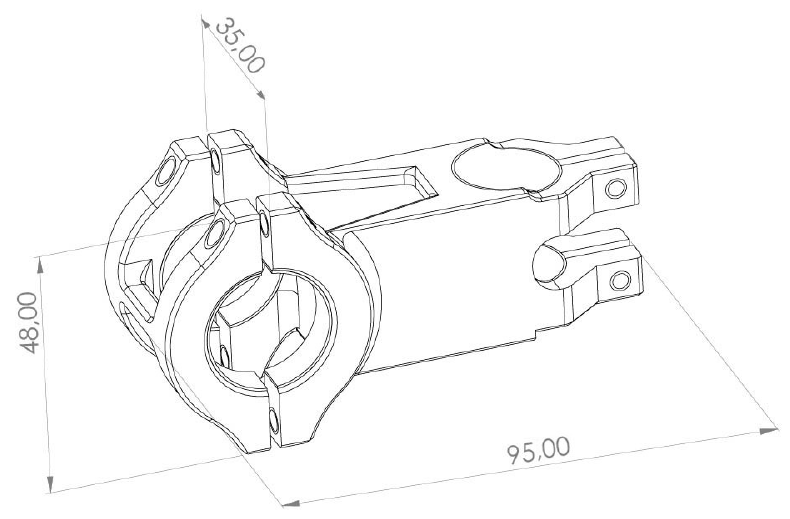
Figure 4. Main dimensions of the bicycle stem designed in the software SolidWorks™.